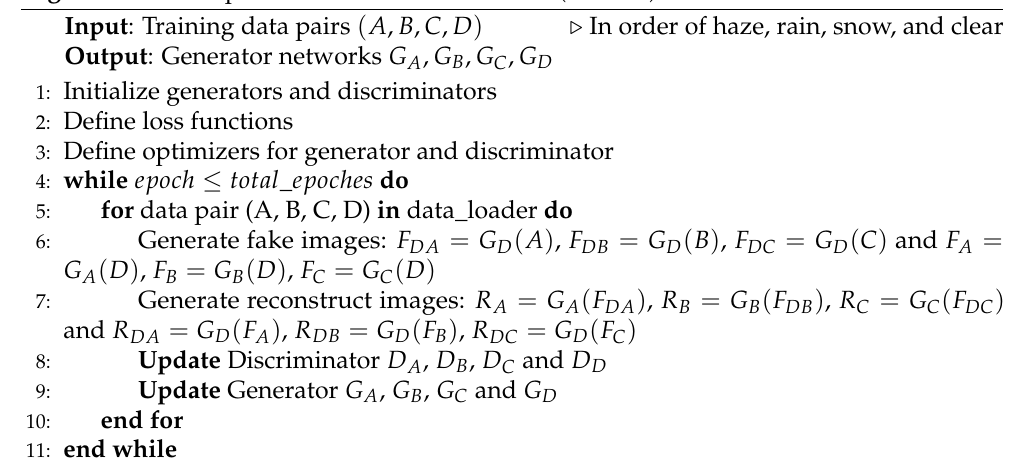
Figure 1. Architecture of proposed Multiple Weather Translation GAN. MWTG consists of four generators corresponding to four mappings: Y → x 1 , Y → x 2 , Y → x 3 , and X → Y . All the generators have a ResNet encoder–decoder with nine residual blocks. Their associated discriminators are a three-layer CNN and output a one-channel prediction map. The weather layers, which are obtained by subtracting the fake output from the input, are used as information guidance to achieve better results. Note that A ∼ D represent hazy, rainy, snowy, and clear weather, respectively, and that G A ∼ D are the respective networks used for generating these weather effects. Algorithm 1 Multiple Weather Translation GAN